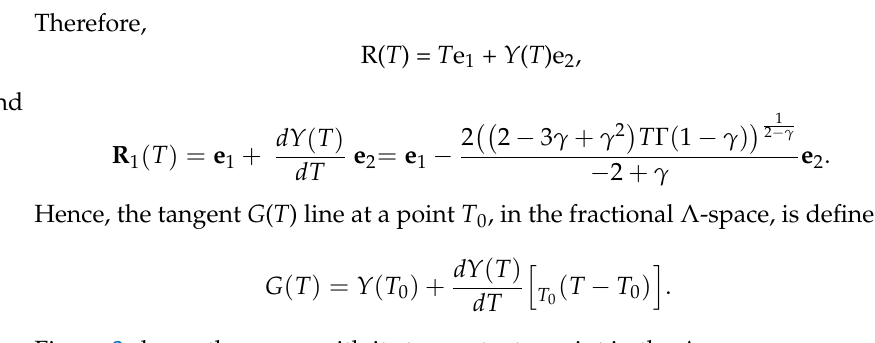
Figure 2. The conjugate curve in the fractional Λ - space.